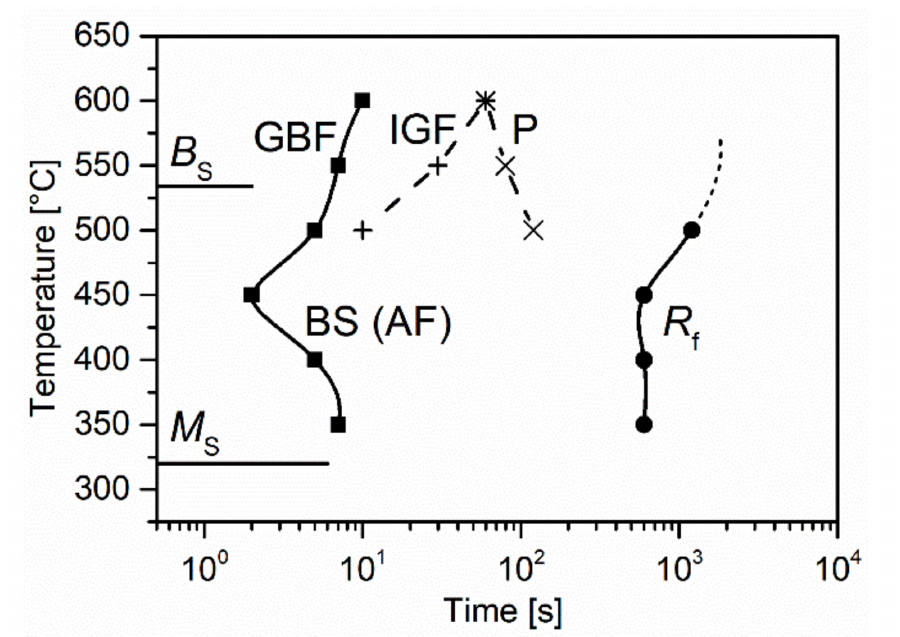
Figure 1. Experimental TTT diagram with corresponding microconstituents indicated: BS, bainite sheaves; AF, acicular ferrite; GBF, grain boundary ferrite; IGF, intragranular ferrite; and P,